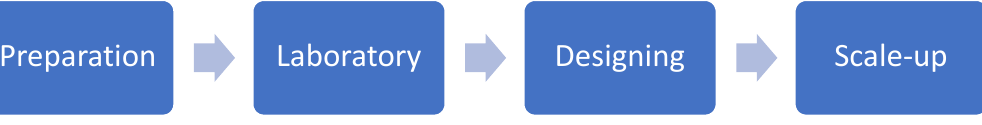
Figure 19. Basic steps for new catalyst development.